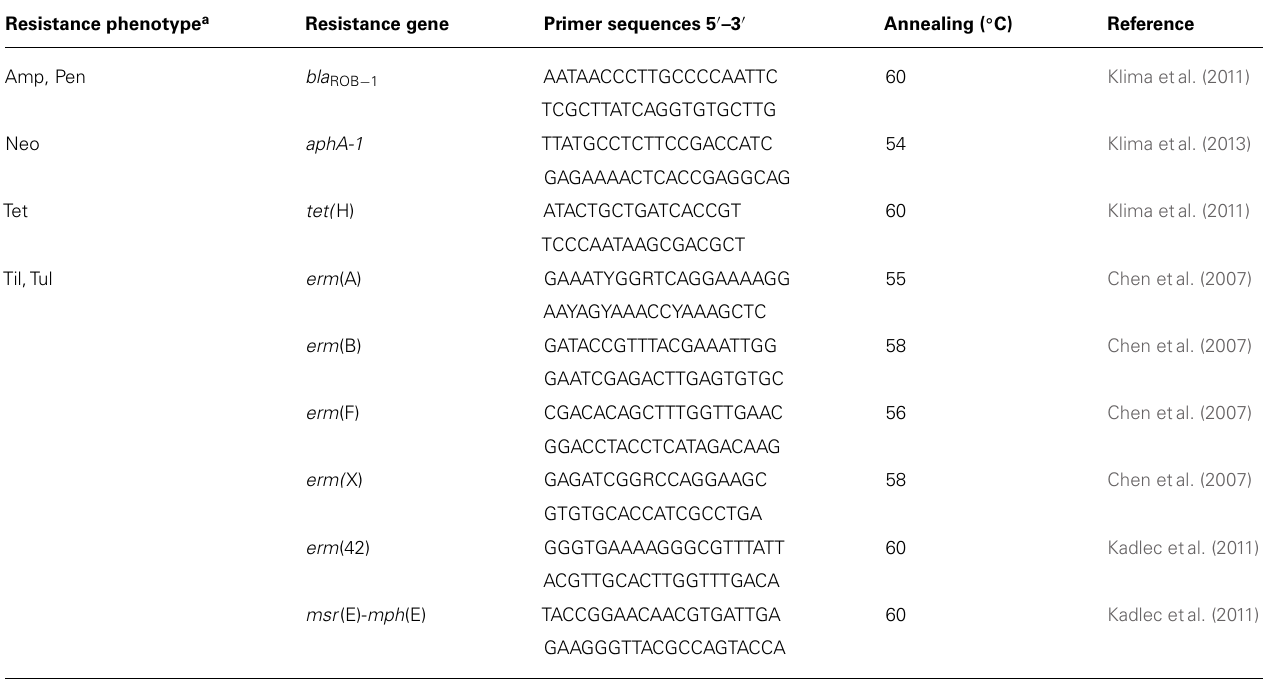
Table 2 | Primers used to screen for antimicrobial resistance genes in M. haemolytica isolated from feedlot cattle. Resistance phenotype a